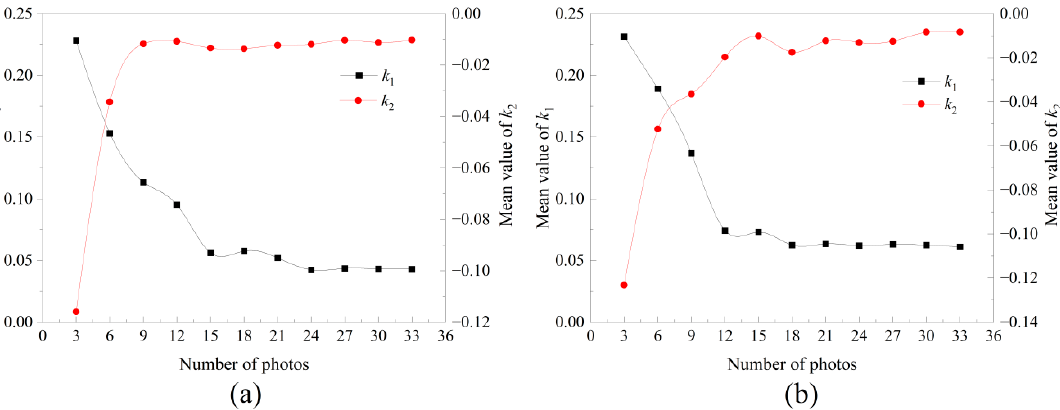
Figure 4. Recognition trend of radial distortion coefficient: ( a ) Parameter recognition of Honor X10 smartphone; ( b ) iPhone 12 smartphone parameter recognition.